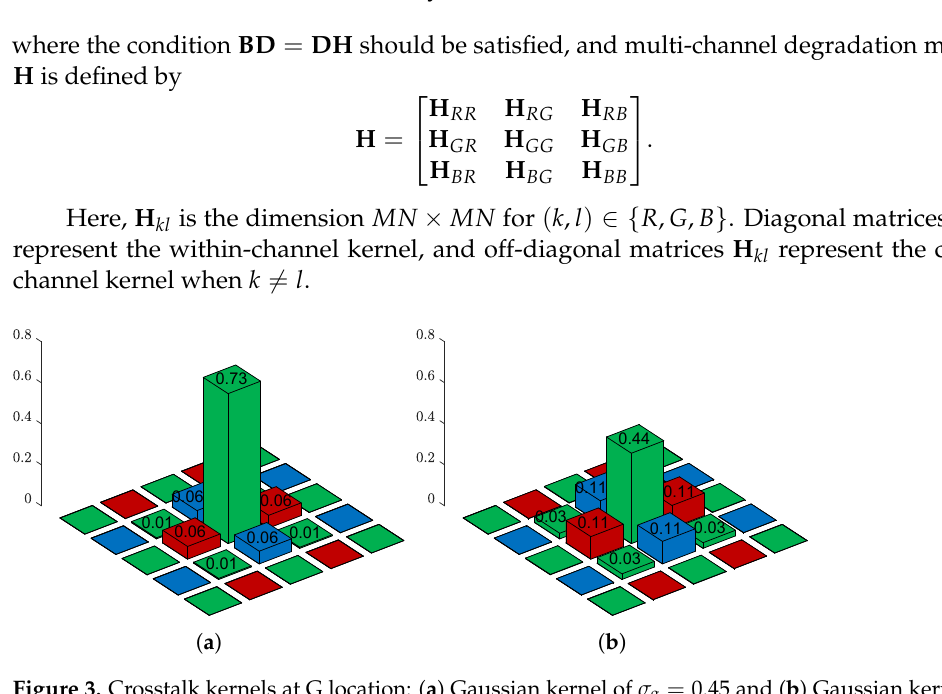
Figure 3. Crosstalk kernels at G location: ( a ) Gaussian kernel of σ g = 0.45 and ( b ) Gaussian kernel of σ g = 0.60. Owing to the crosstalk kernel, spectral and spatial degradation simultaneously